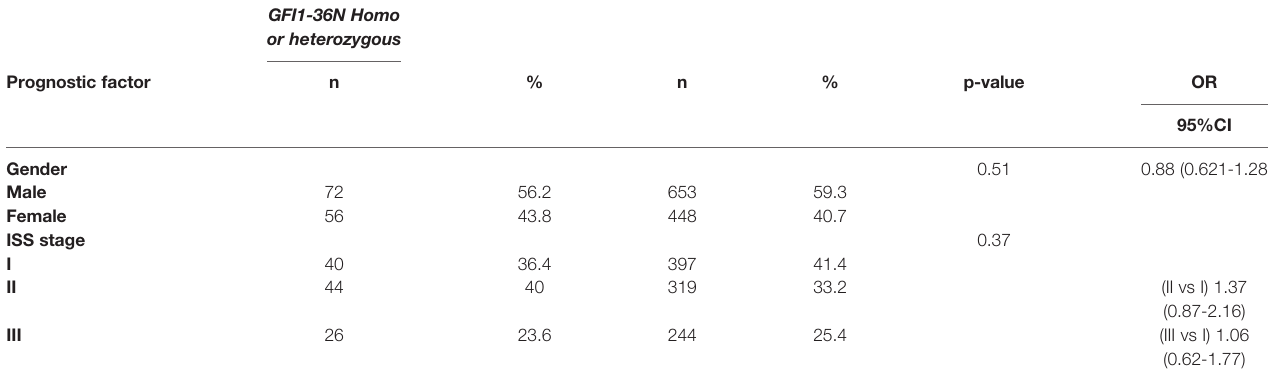
TABLE 2 | Clinical factors and their association with GFI136N. No signi fi cant association between the presence of the GFI1-36N allele and gender or ISS was observed. GFI1-36N Homo or heterozygous Prognostic